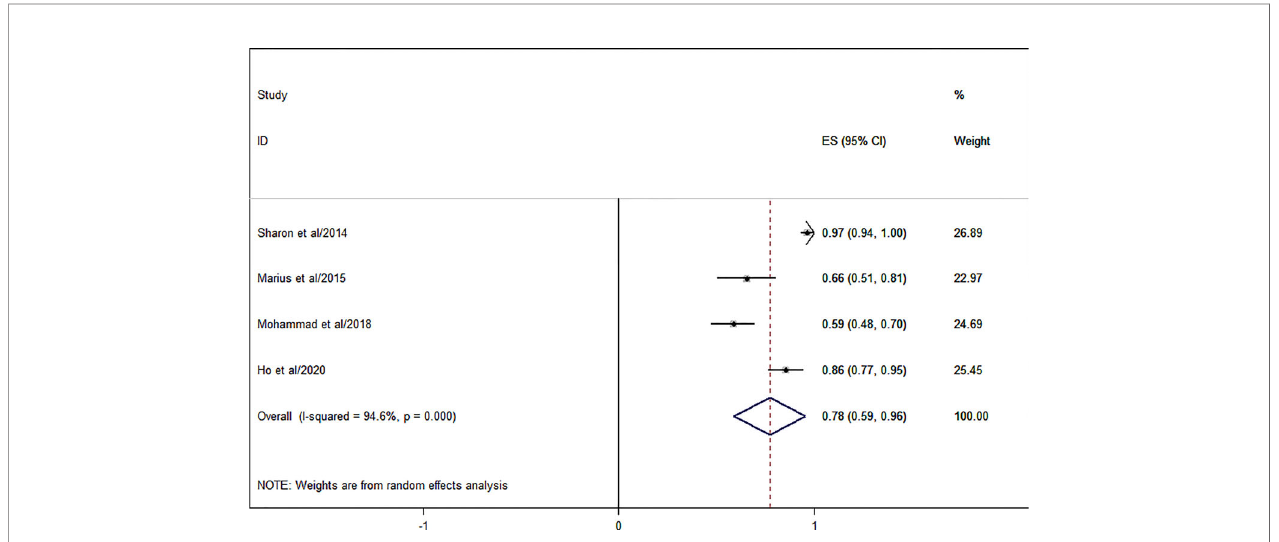
FIGURE 6 | Forest plot of the pooled concordance rate for whole-body MRI (WB-MRI) compared to reference